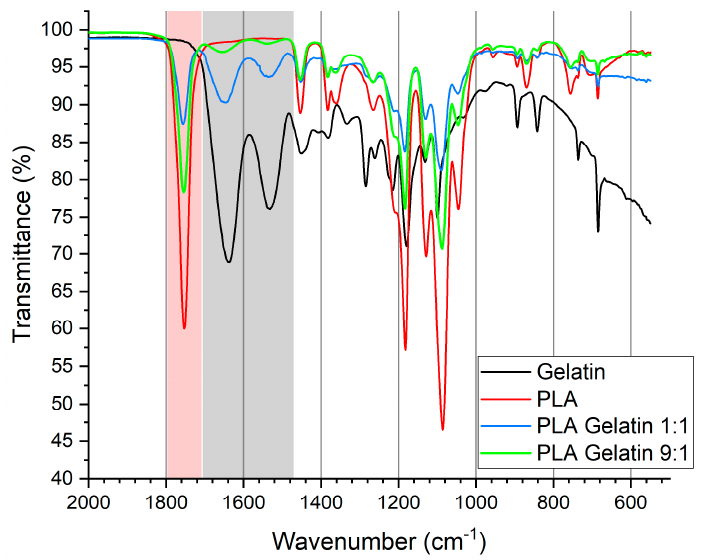
Figure 2. FTIR spectra of electrospun gelatin, PLA, PLA–gelatin (1:1) blend, and PLA–gelatin (9:1) blend.